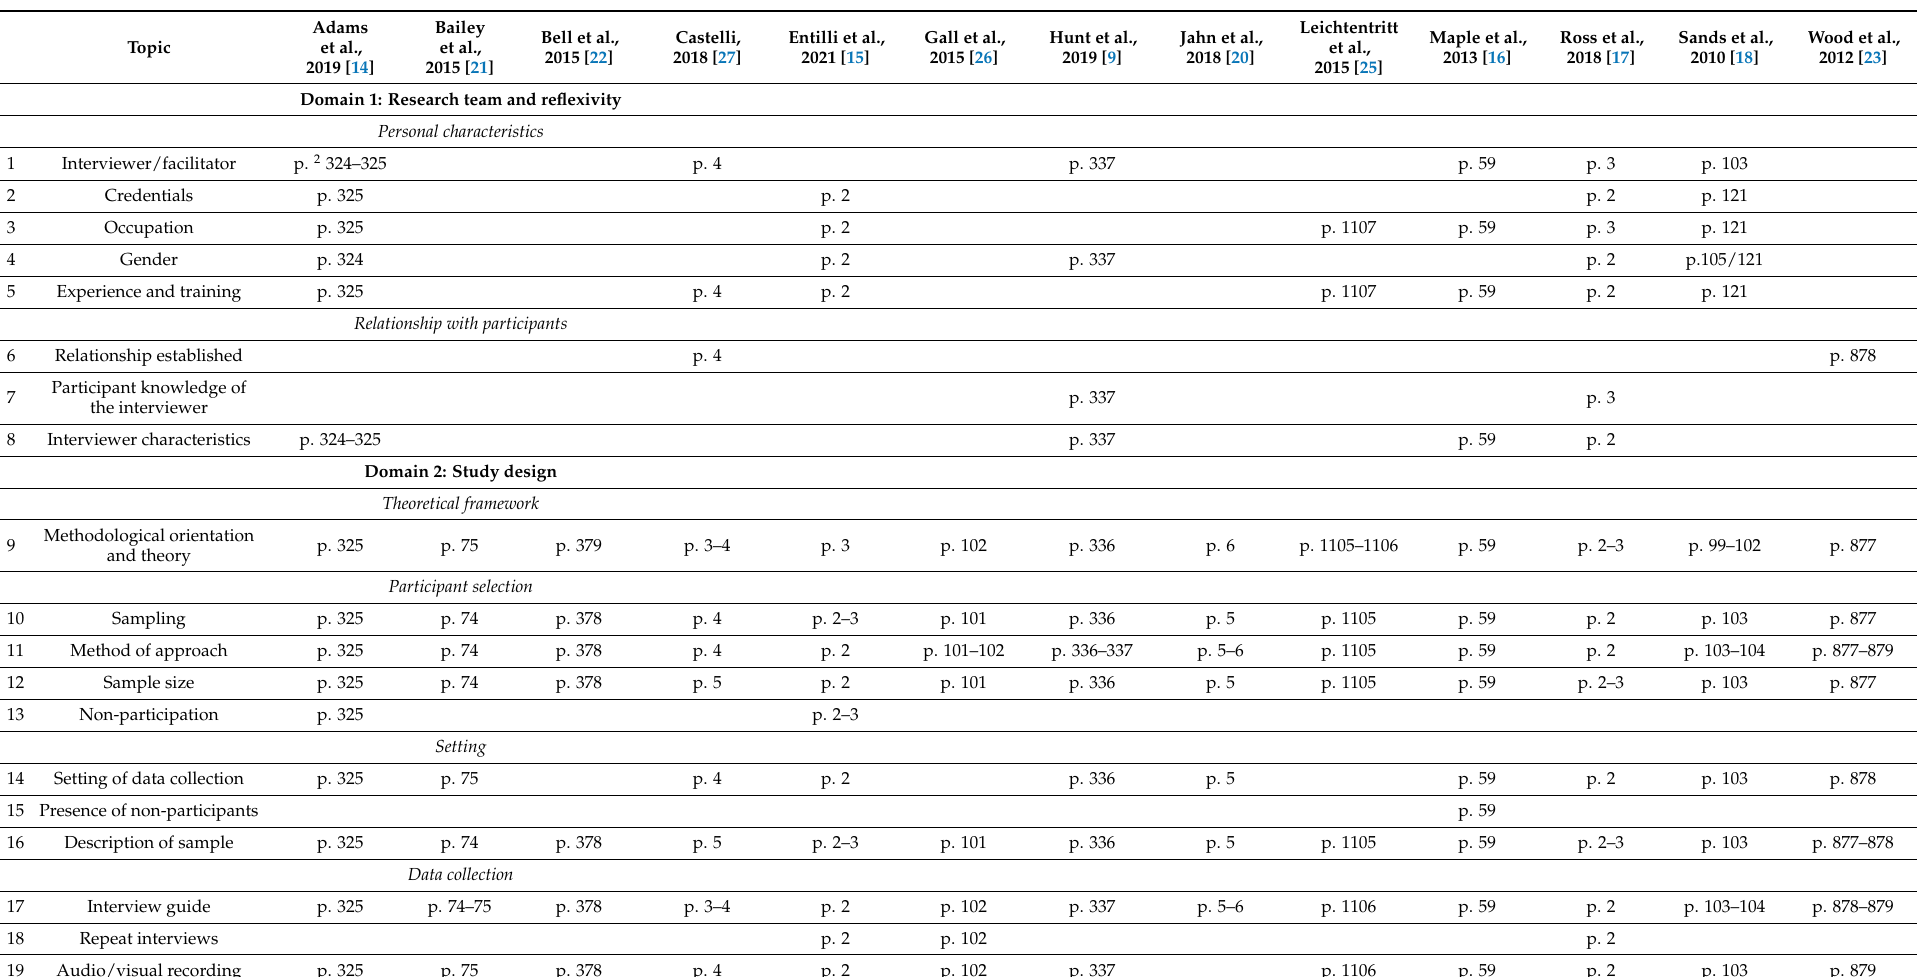
Table A2. Quality assessment 1 of qualitative